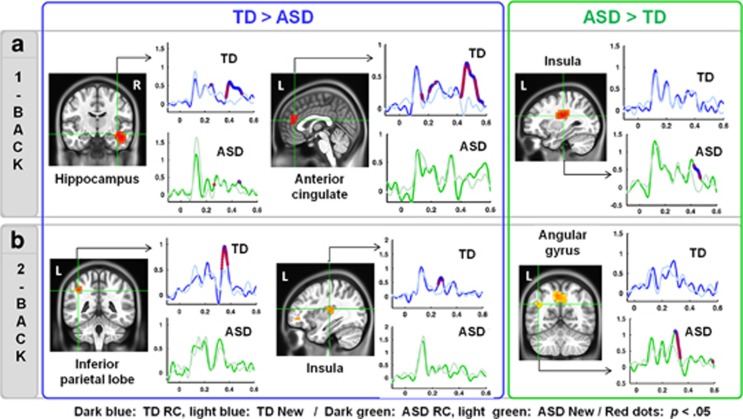
WM-related brain differences between TD and ASD children in (a) the 1-back and (b) the 2-back conditions. Brain images: significant brain activations associated with correct recognition effects (RC>New, P<0.5 corrected) that were stronger in TD children than children with ASD (left panel in blue) or stronger in children with ASD than in TD children (right panel in green, all P<0.005). Each brain image is associated with two overlaid time-course plots (y axes: pseudo z-values; x axes: time in seconds) representing statistical comparisons (P<0.5, red dots) between virtual sensors associated with RC (dark blue in TD and dark green in ASD children) and New (light blue in TD and light green in ASD children) trials. ASD, autism spectrum disorder; RC, repeat–correct' trial; TD, typically developing children.